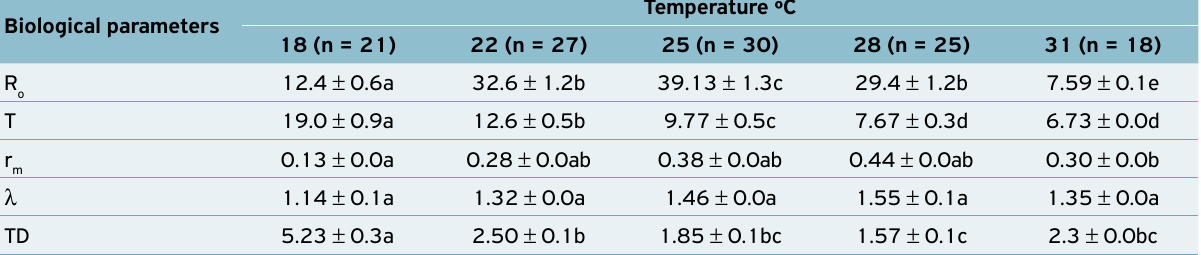
Table 4. Population and biological parameters ( ± SE) of Aphis craccivora in cowpeas under constant temperatures. Biological